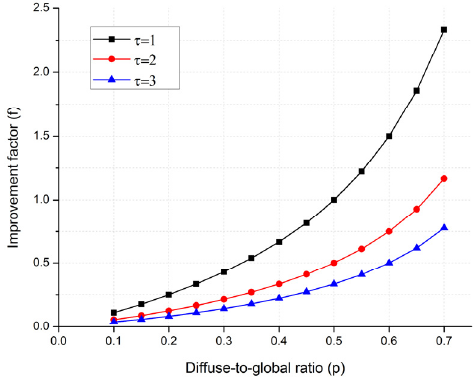
Figure 13. Improvement factor vs. diffuse ‐ to ‐ global ratio.